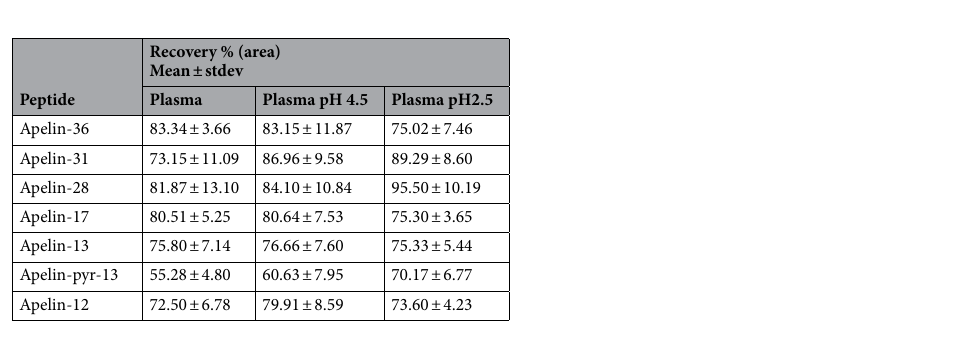
Table 4. Recovery experiment based calculated on area (n = 6). The recovery was determined by adding a fixed concentration of the peptides both at the beginning of sample preparation and at the end.